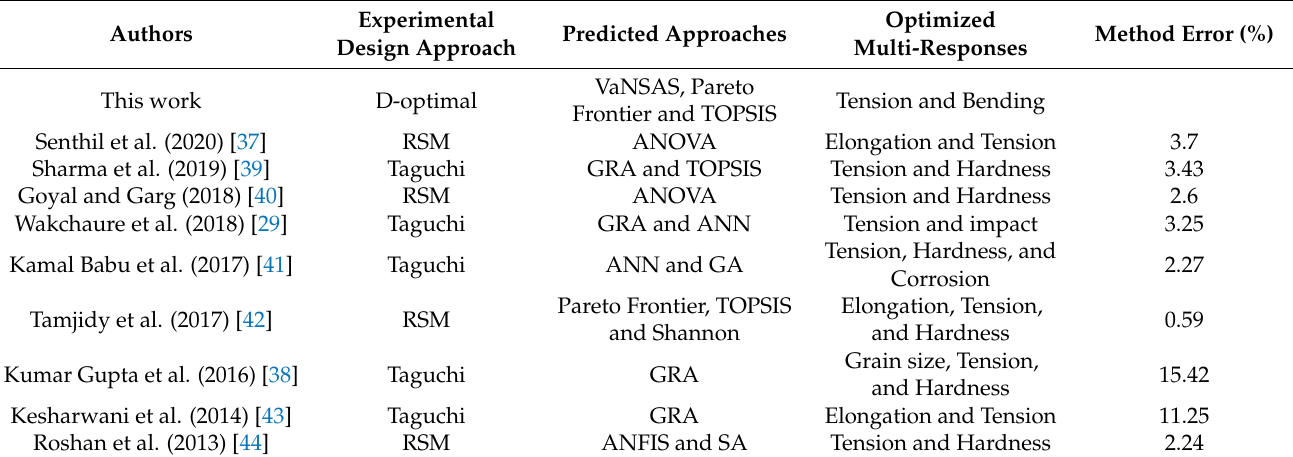
Table 1. Prediction approaches and response optimization from literature